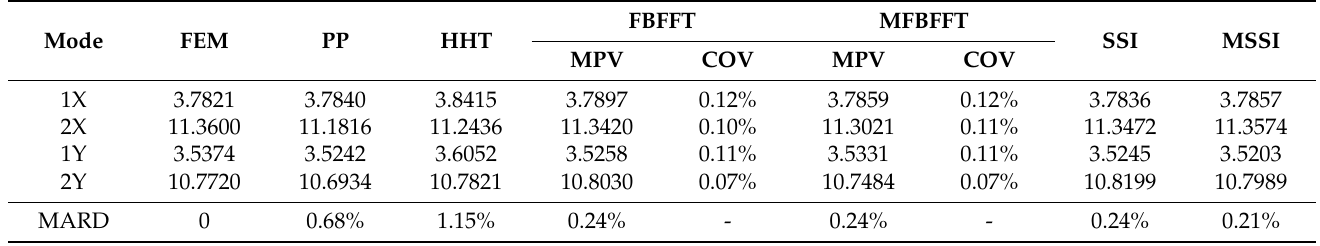
Table 1. Identified natural frequencies (Hz) of four sway modes for a numerical model of the structure.